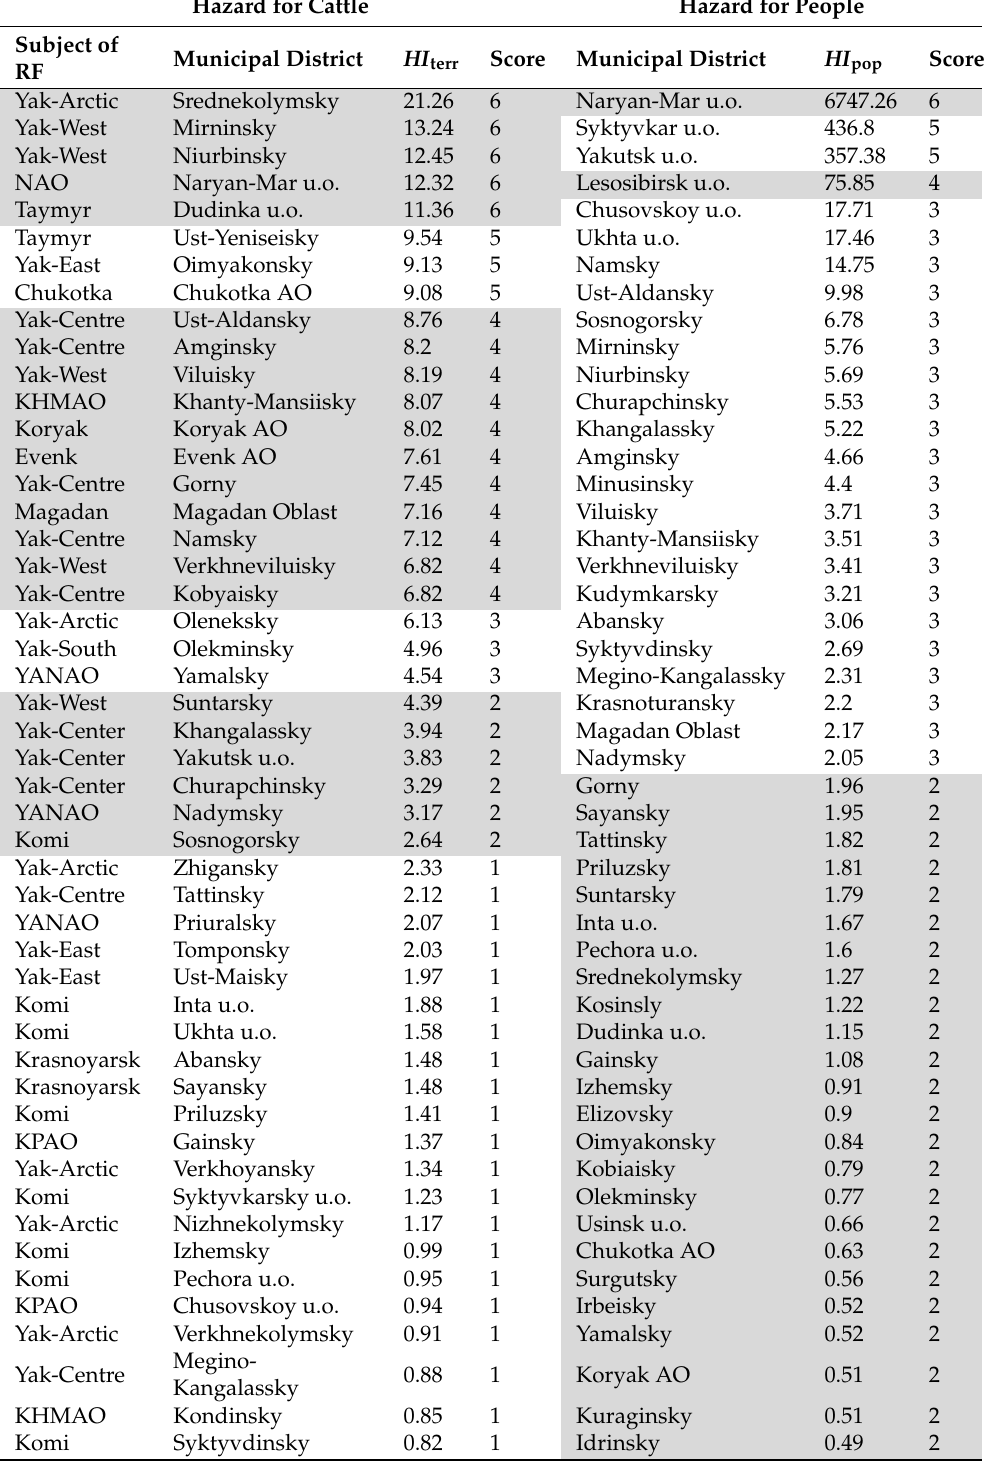
Table 1. Ranking of municipal districts by relative hazard of outbreaks of Siberian anthrax among cattle (using the territorial hazard index) and people (using the population hazard